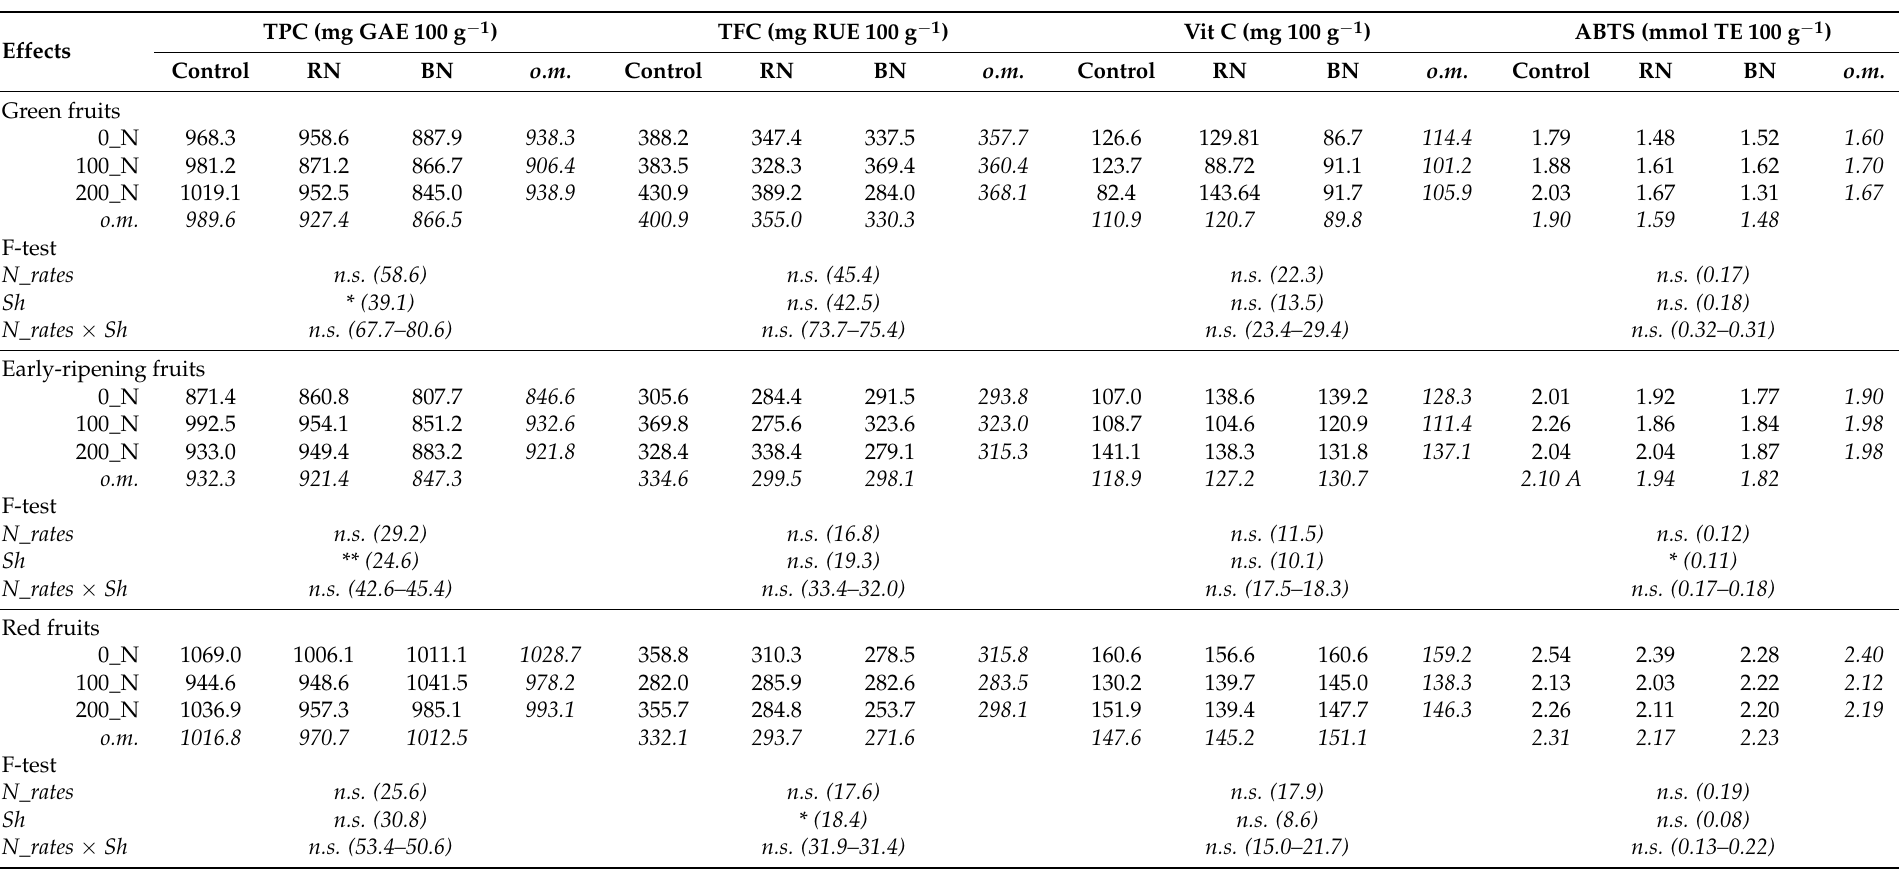
Table 4. Total phenolic content [TPC, mg gallic acid equivalent (GAE) 100 g − 1 dry weight (DW)], total flavonoid content [TFC, mg rutin equivalents (RUE) 100 g −